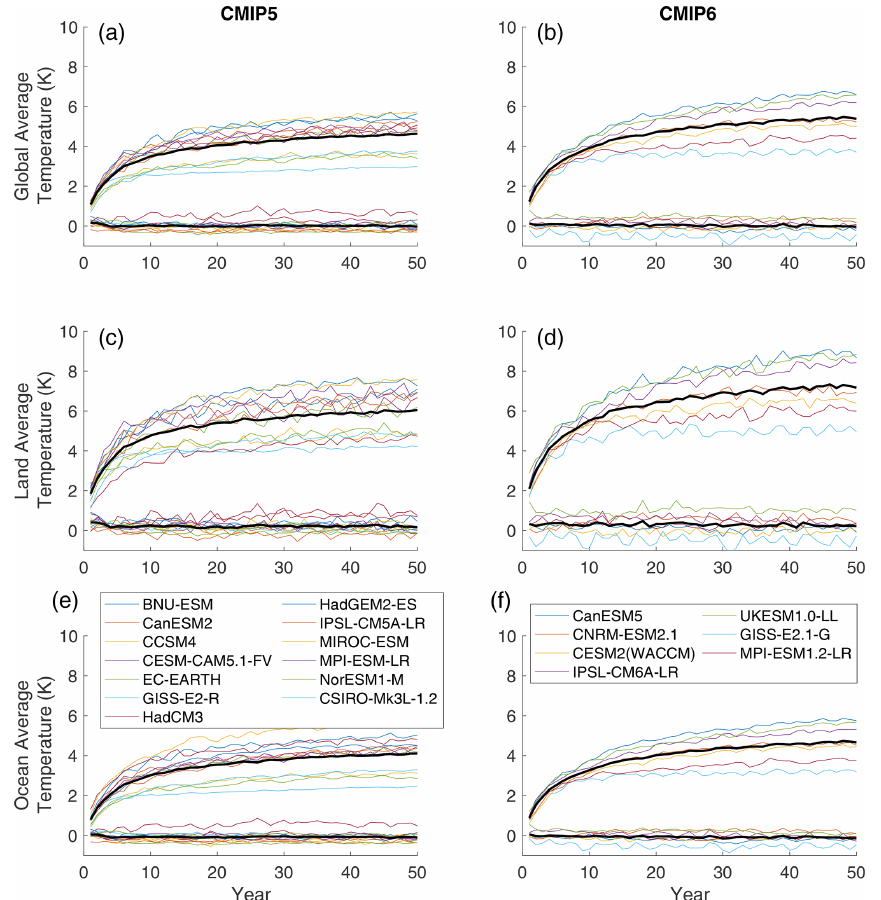
Figure 6. Global mean (a, b) , land mean (c, d) , and ocean mean (e, f) temperature change (K) for the CMIP5 (a, c, e) and CMIP6 (b, d, f) . Thin colored lines are individual models, and thick black lines are model means. In all panels, the upper cluster of lines is the abrupt4xCO2 simulation, and the lower cluster of lines (approximately zero temperature change for the entire simulation) is experiment